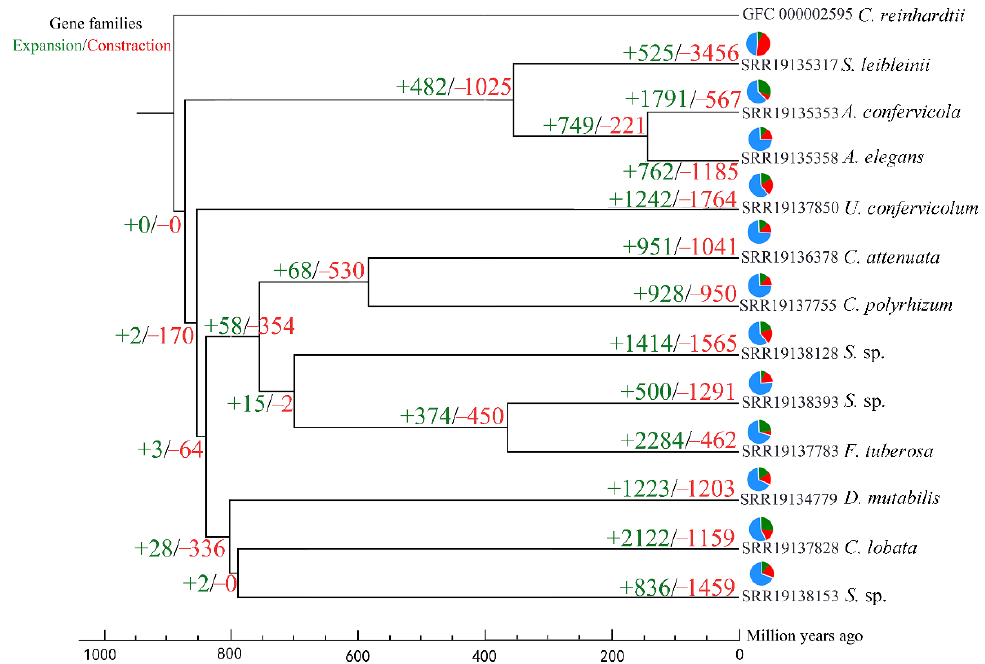
Figure 1. 143 single-copy orthogroups were used to construct the phylogenetic tree for the order Chaetophorales. The numbers on the nodes correspond to the bootstrap support values (BP)/posterior probabilities (PP). The scale bar represents the genetic distances, which are proportional to branch lengths. The Schizomeridaceae and Aphanochaetaceae family clade is indicated by the gray backdrop.